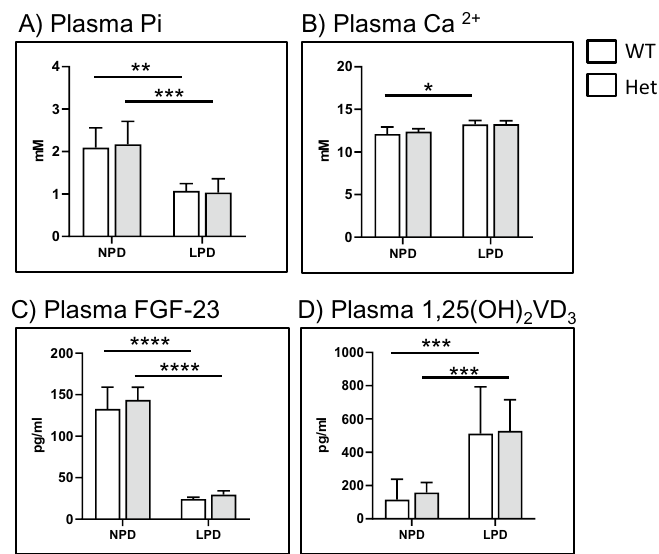
Figure 3. ( A ) Plasma Pi, ( B ) plasma Ca 2+ , ( C ) plasma intact FGF-23 and ( D ) plasma 1,25(OH) 2 vitamin D 3 of wild type (n = 4) and heterozygous (n = 5) Slc34a2 rats fed standard chow (NPD) or challenged for 3 days with low Pi diet (LPD). Data are presented as means ± SEM. Statistical significance was calculated by ANOVA- Bonferroni. * P ≤ 0.05, ** P ≤ 0.01, *** P ≤ 0.001, and **** P ≤ 0.0001.